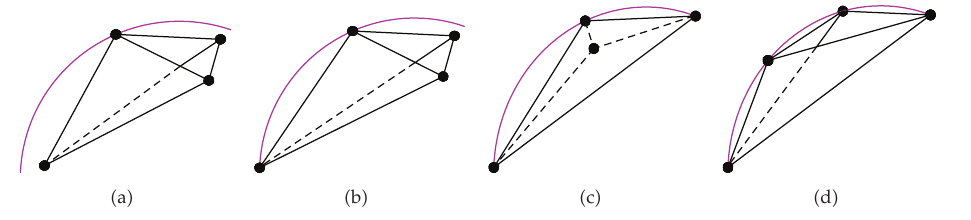
Figure 1: Four kinds of boundary